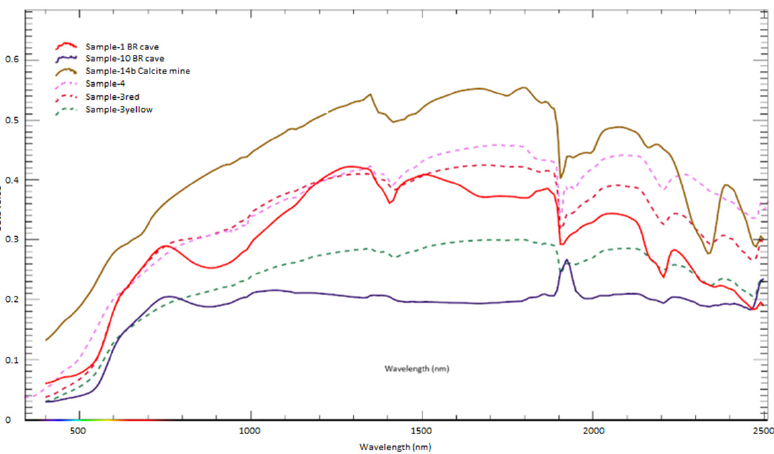
Figure 7. Comparison between spectrum signature of samples from bauxite residues and detected coordinates by PRISMA and Sentinel-2 band ratio analysis.